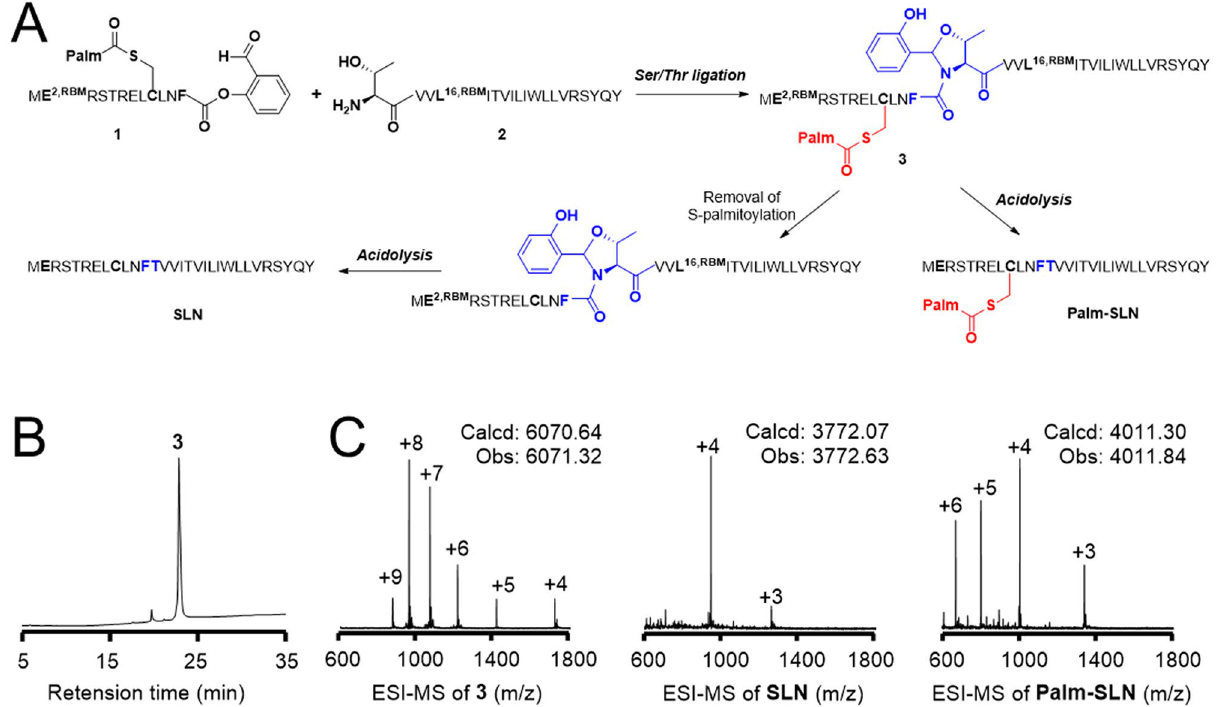
Figure 2. Chemical synthesis of pSLN and SLN by the RBM GABA -based STL method. ( A ) The synthetic